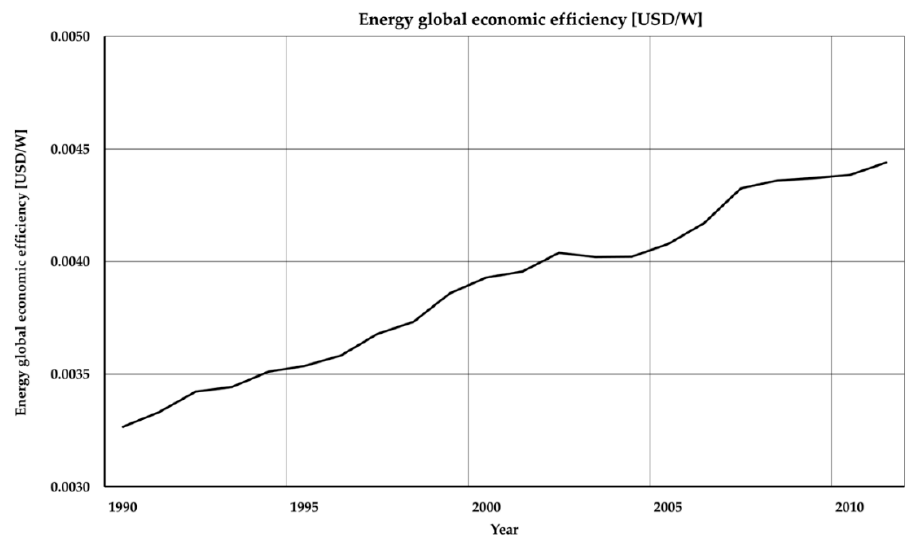
Figure 6. Energy economic efficiency, defined as energy intensity (as defined by IEA: TPES divided by the GDP) as ratio of W/USD from year 1990 to year 2011. Power data derive from IEA, while GDP data (actualized to year 2011) are available from Earth Policy Institute online database [52].